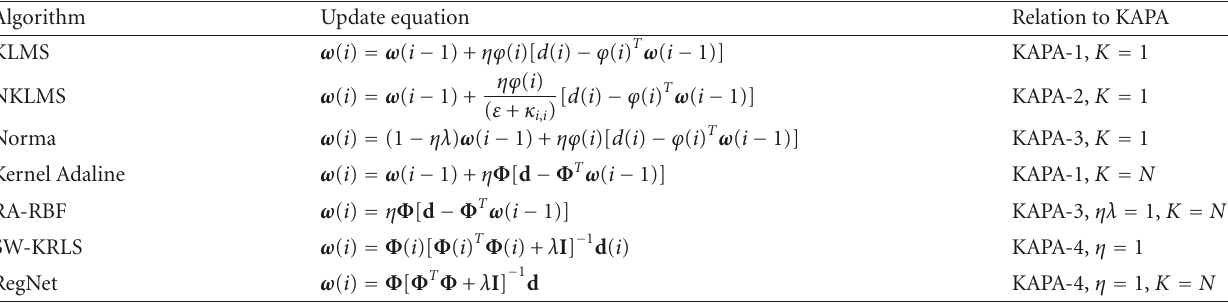
Table 3: List of related